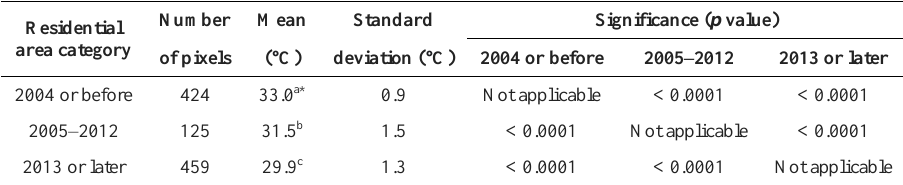
Table 1. Mean land surface temperature for the residential area categories